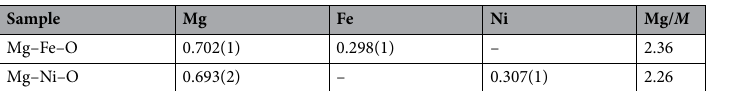
Table 1. Metal composition ratios of Mg– M –O ( M = Fe or Ni) after the decomposition of the precipitates.